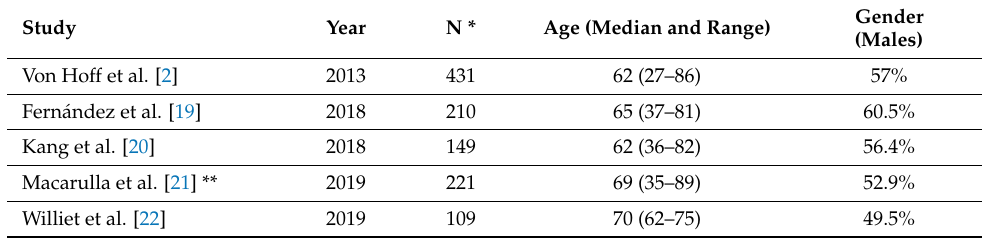
Table 1. Baseline characteristics of the 14 studies involved for the calculation of the reference PFS and for this study (the PaCT study). *: Only patients treated with N–G. **: For these studies the combined population of two arms (both treated with N–G) was used, age was calculated as the weighted average of the two arms. ***: For this study the part of the population that continued therapy was